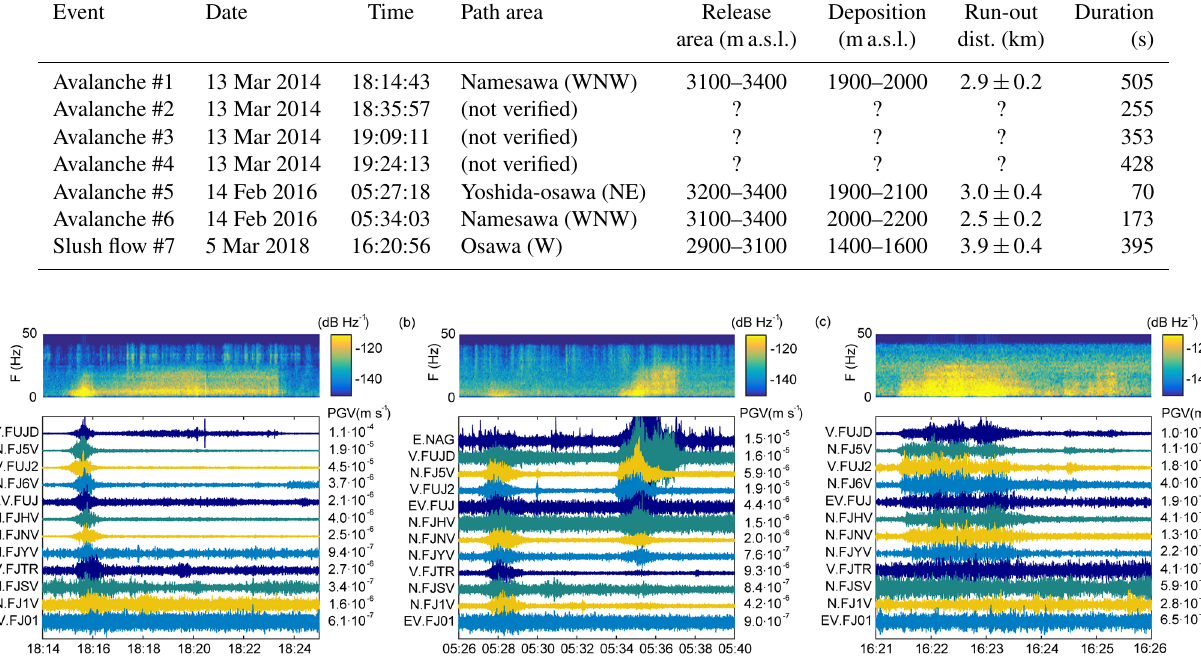
Figure 3. (a) Spectrogram (computed at V.FUJD station) and vertical seismograms generated by avalanche #1 released on 13 March 2014. Each trace is normalized by its maximum amplitude (peak ground velocity, PGV). (b) Spectrogram (V.FUJD station) and vertical seismo- grams generated by the consecutive avalanches #5 and #6 released on 14 February 2016. Each trace is normalized by the maximum amplitude generated by avalanche #5. Seismic data from N.FJ6V station were not available this day but there were data from the temporary E.NAG station. (c) Spectrogram (V.FUJD station) and time series recordings of the normalized vertical seismograms generated by slush flow